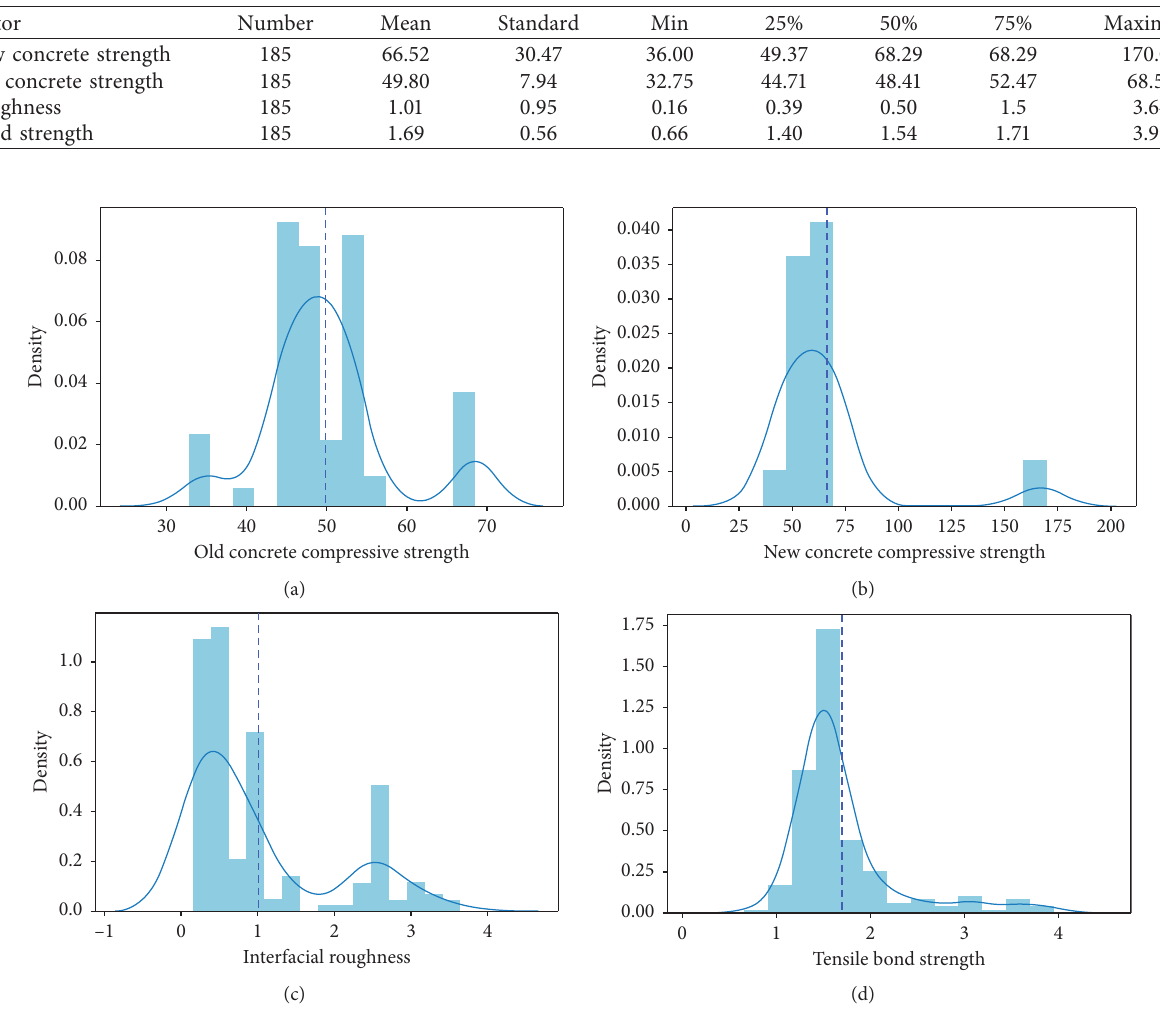
Figure 14: Workflow of the ensemble machine learning model. Table 6: Statistical information of parameters included 185 experimental data.